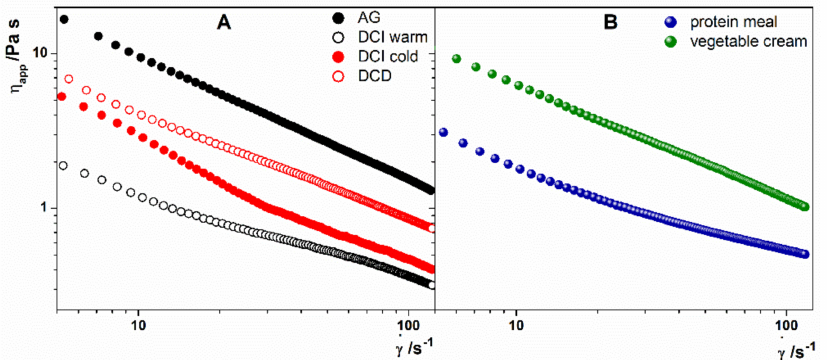
Figure 1. ( A ) Flow curves of AG (full black circles), DCI hydrated with warm water (open black circles), DCI hydrated with cold water (full red circles), DCD (open red circles), ( B ) flow curves of Protein Meal (full blue circles) and Vegetable Cream (full green circles).